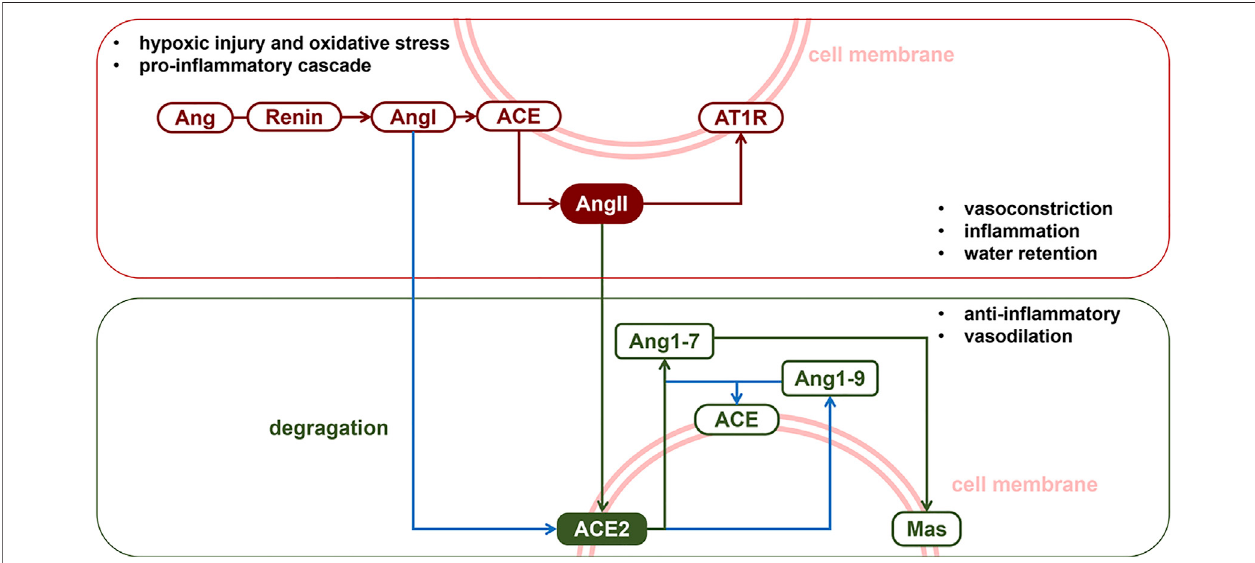
FIGURE 1 | The renin-angiotensin system. The RAS classic axis consists of the membrane protein angiotensin converting enzyme (ACE), vasoconstrictor angiotensinII(AngII)anditsspeci fi creceptortype1angiotensinIIreceptor(AT 1 R).ActivationofACE-AngII-AT 1 Rpathwaycouldinducepulmonaryvasospasmoraseptic in fl ammation. Meanwhile, autocrine or paracrine signalling of AngII was counterbalanced by membrane protein ACE2, which, with ACE, degragates AngI and AngII into protein fragments Ang1-7. The ACE2-Ang1-7-Mas pathway, also called the protective arm of RAS, exhibits a protective action in the